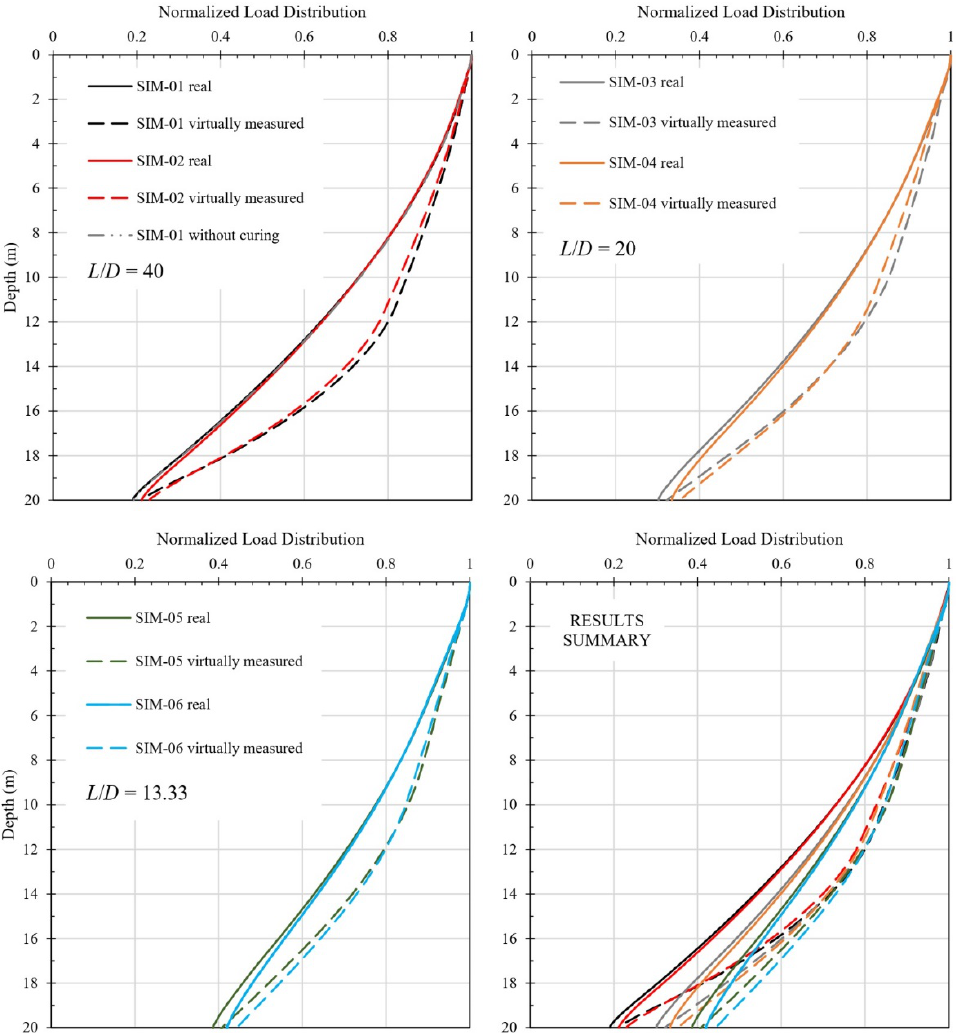
Figure 13. Normalized load distribution curves for 20 m long non-displacement drilled shafts for analyses with L / D = 40 (SIM-01 and SIM-02), L / D = 20 (SIM-03 and SIM-04), and L / D = 13.33 (SIM-05 and